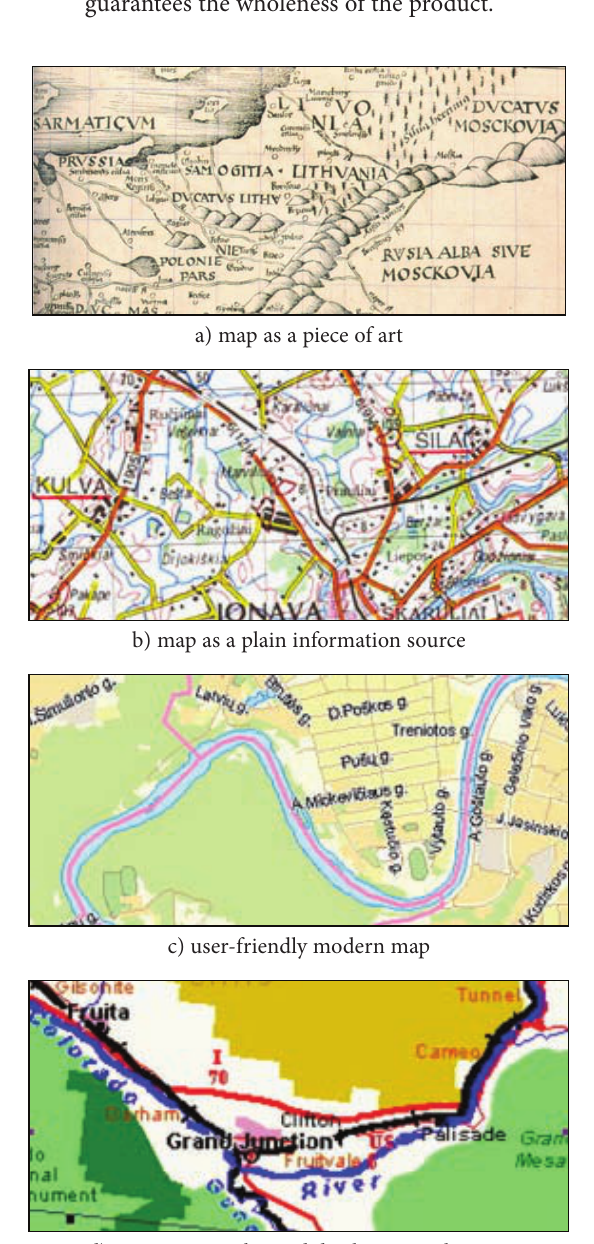
Fig. 1. Reflection of the cartographer–user relationship on the style of a